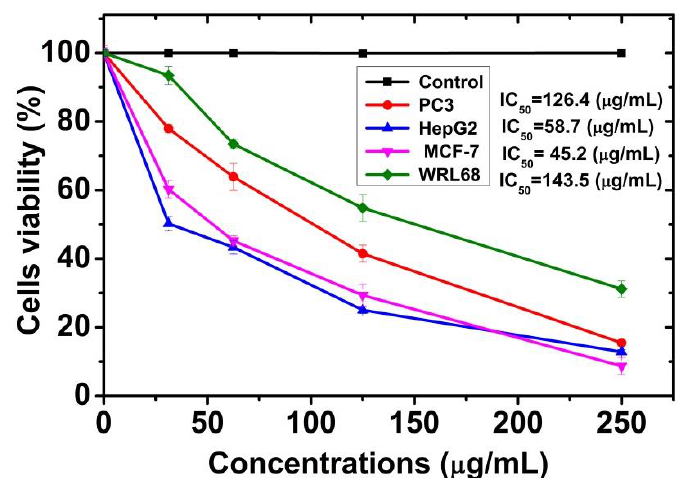
Figure 8. Viability of normal WRL68 cell and cancer cells (PC3, HepG2, and MCF-7), cells treated with different concentrations of CuO @OVLe NCs . Numerical data are described as the mean ± SD ( n = 3).